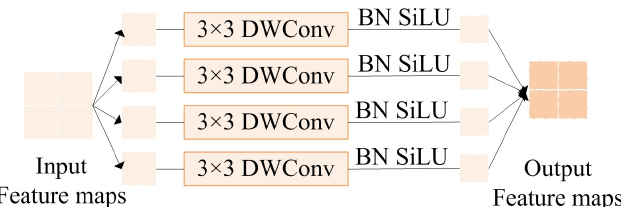
Figure 5. Local-feature